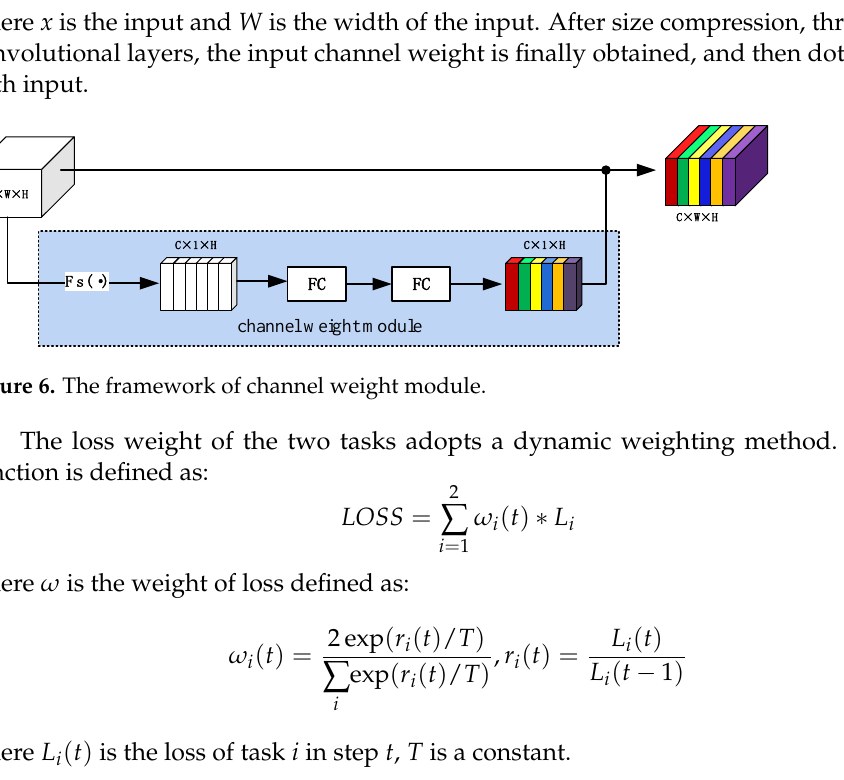
Figure 5. The overall framework of the model.